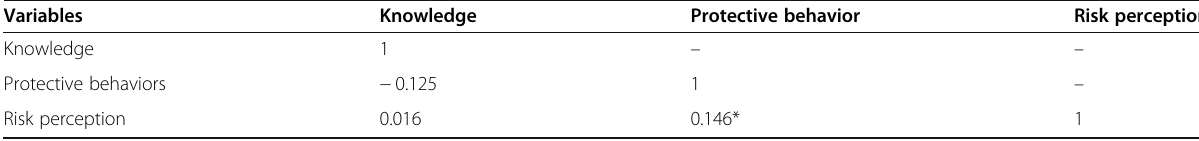
Table 4 Correlations between COVID-19-related knowledge, protective behaviors, and risk perception among pregnant women Variables Knowledge Protective behavior Risk perception Knowledge 1 – – Protective behaviors − 0.125 1